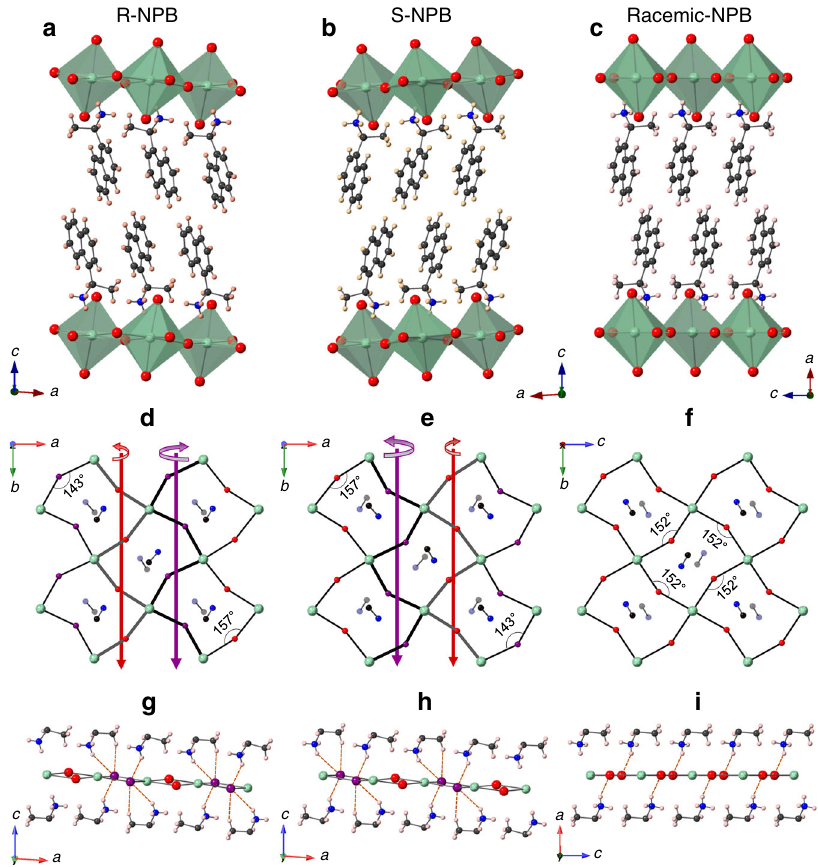
Fig. 1 Structural characteristics of chiral- and racemic-NPB. a – c Schematic X-ray single-crystal structures of a R -NPB, b S -NPB, and c racemic-NPB. d , e In-plane views of [PbBr 4 ] 2 − layers in d R -NPB and e S -NPB show two different equatorial Pb – Br – Pb bond angles of 143° and 157° associated with two different Br atoms, denoted as purple and red spheres, respectively. The axial Br atoms are omitted for clarity. Opposite and dissimilar out-of-plane helical distortions (indicated by small and big curved arrows) of red and purple Br atoms can be seen from the spiraling of corresponding Pb – Br – Pb bonds (marked by thicker black and gray lines in d and e ) around the 2 1 -screw axes (red and purple arrows). f Racemic-NPB shows a single equatorial Pb – Br – Pb bond angle of 152° with no out-of-plane distortions of Br atoms. Also shown in d – f are the organic terminal -CH-NH 3 + groups, represented as solid and shaded dumbbells for the upper and lower organic layers, respectively. g – i , Hydrogen-bonding interactions between the equatorial Br atoms and NEA + cations in g R -NPB, h S -NPB, and i racemic-NPB. The axial Br atoms and associated interactions are omitted for clarity. The out-of-plane distortions of equatorial Br atoms in d and e are clearly seen in g and h for R -NPB and S -NPB, respectively. Green, red/purple, black, blue, and pink spheres denote Pb, Br, C, N, and H atoms,